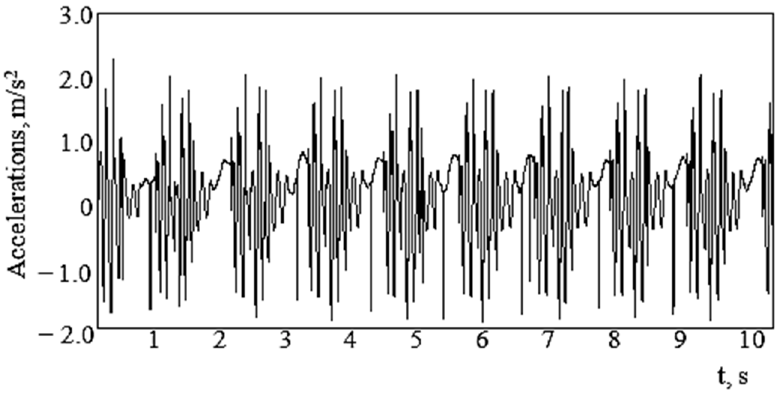
Figure 5. Acceleration acting on the container in the vertical plane.